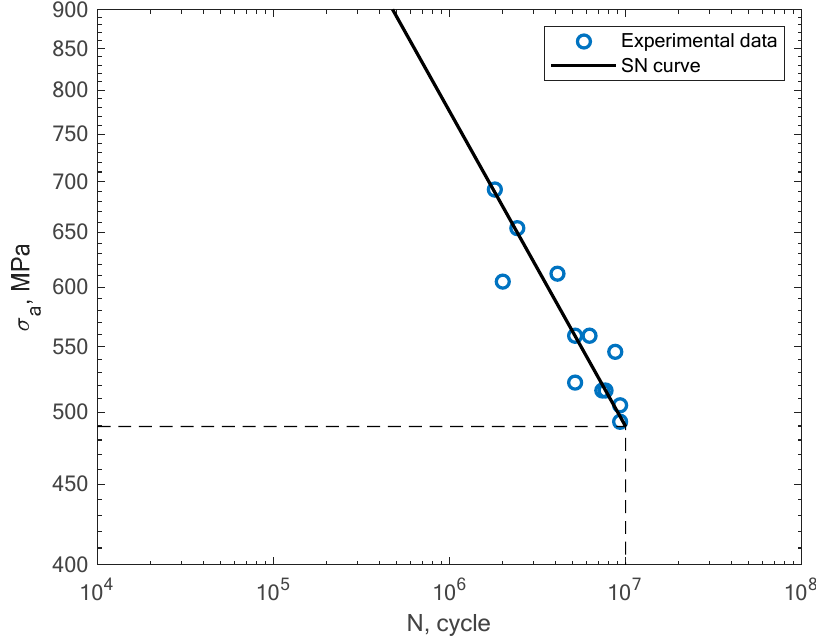
Figure 14. S–N curve for the experimental bending fatigue test results reported by Kostic et al. [2] for the case of heat treatment and machining.